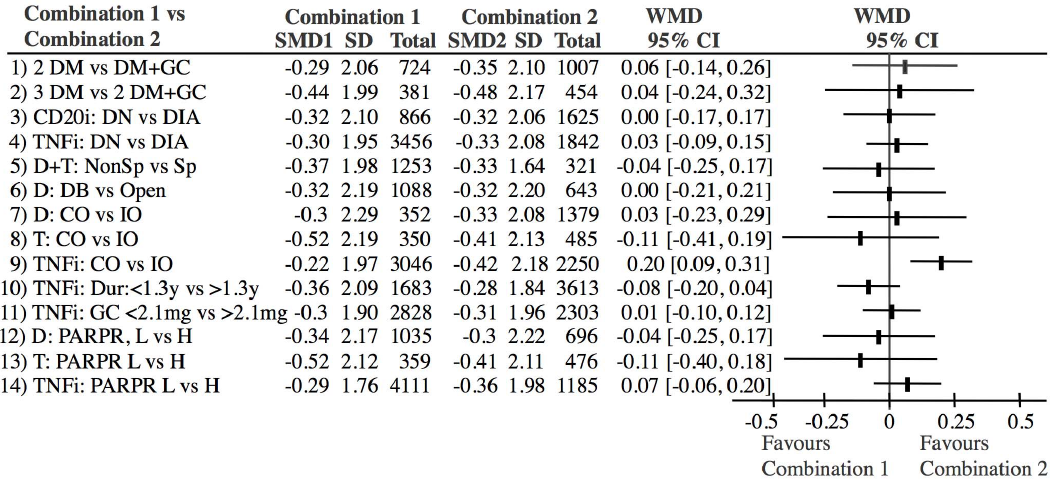
analysis (I 2 = 42%) (Figure 6) was due to two golimumab studies [46]. Elimination of these studies reduced heterogeneity (I 2 =27%) but did not change the overall result (SMD: 2 0.33 (CI: 2 0.39, 2 0.27)).